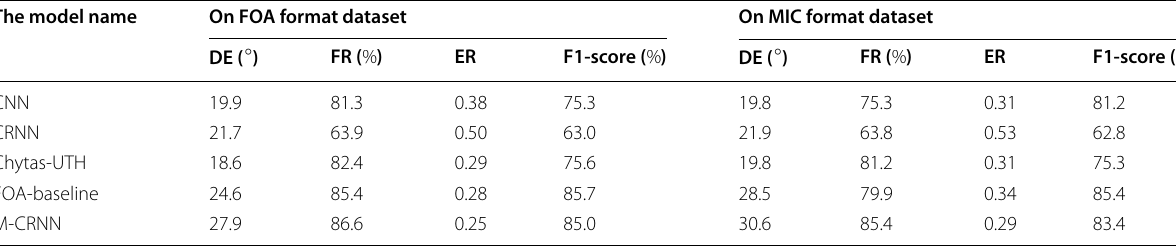
Table 3 Performance evaluation of each model based on the dataset in FOA and MIC format The model